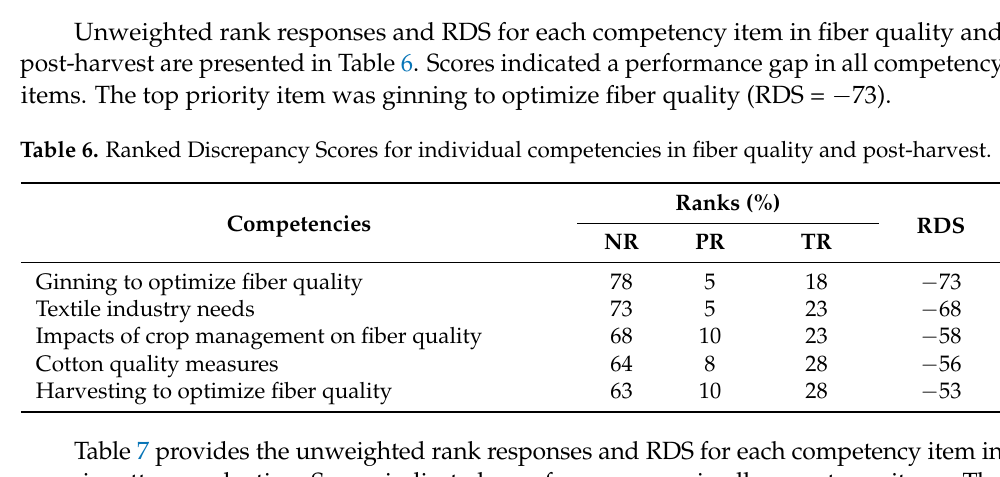
Table 7. Ranked Discrepancy Scores for individual competencies in organic cotton production. Competency Marketing organic cotton fiber and seed